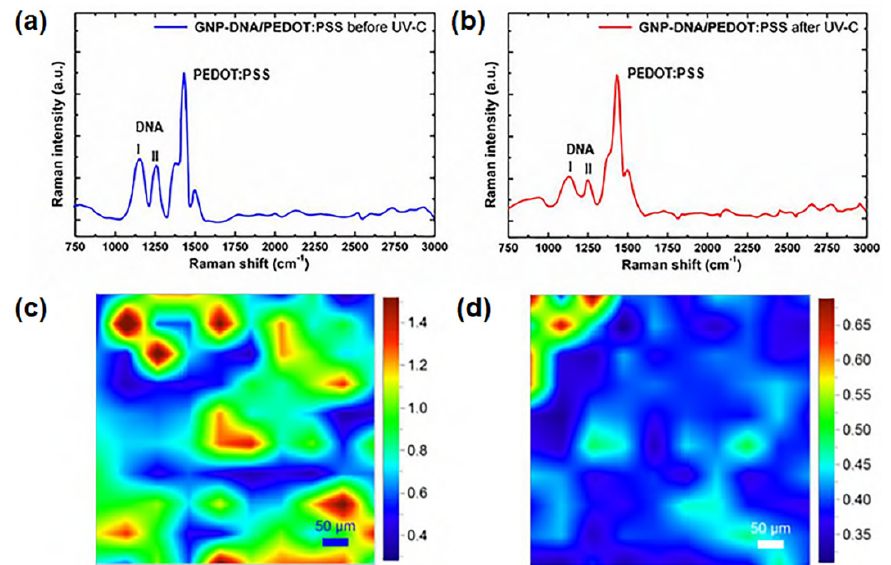
Figure 9. Raman analysis of GNP-DNA/PEDOT:PSS film ( a , c ) non-irradiated and ( b , d ) after UV-C exposure for 6 days. ( a , b ) Raman spectra; ( c , d ) Raman maps obtained using the intensity of the DNA I peak normalized to the intensity of the main PEDOT:PSS peak as contrast parameter. Reproduced with permission from Toto et al., Appl. Surf. Sci.; published by Elsevier, 2020 [33].